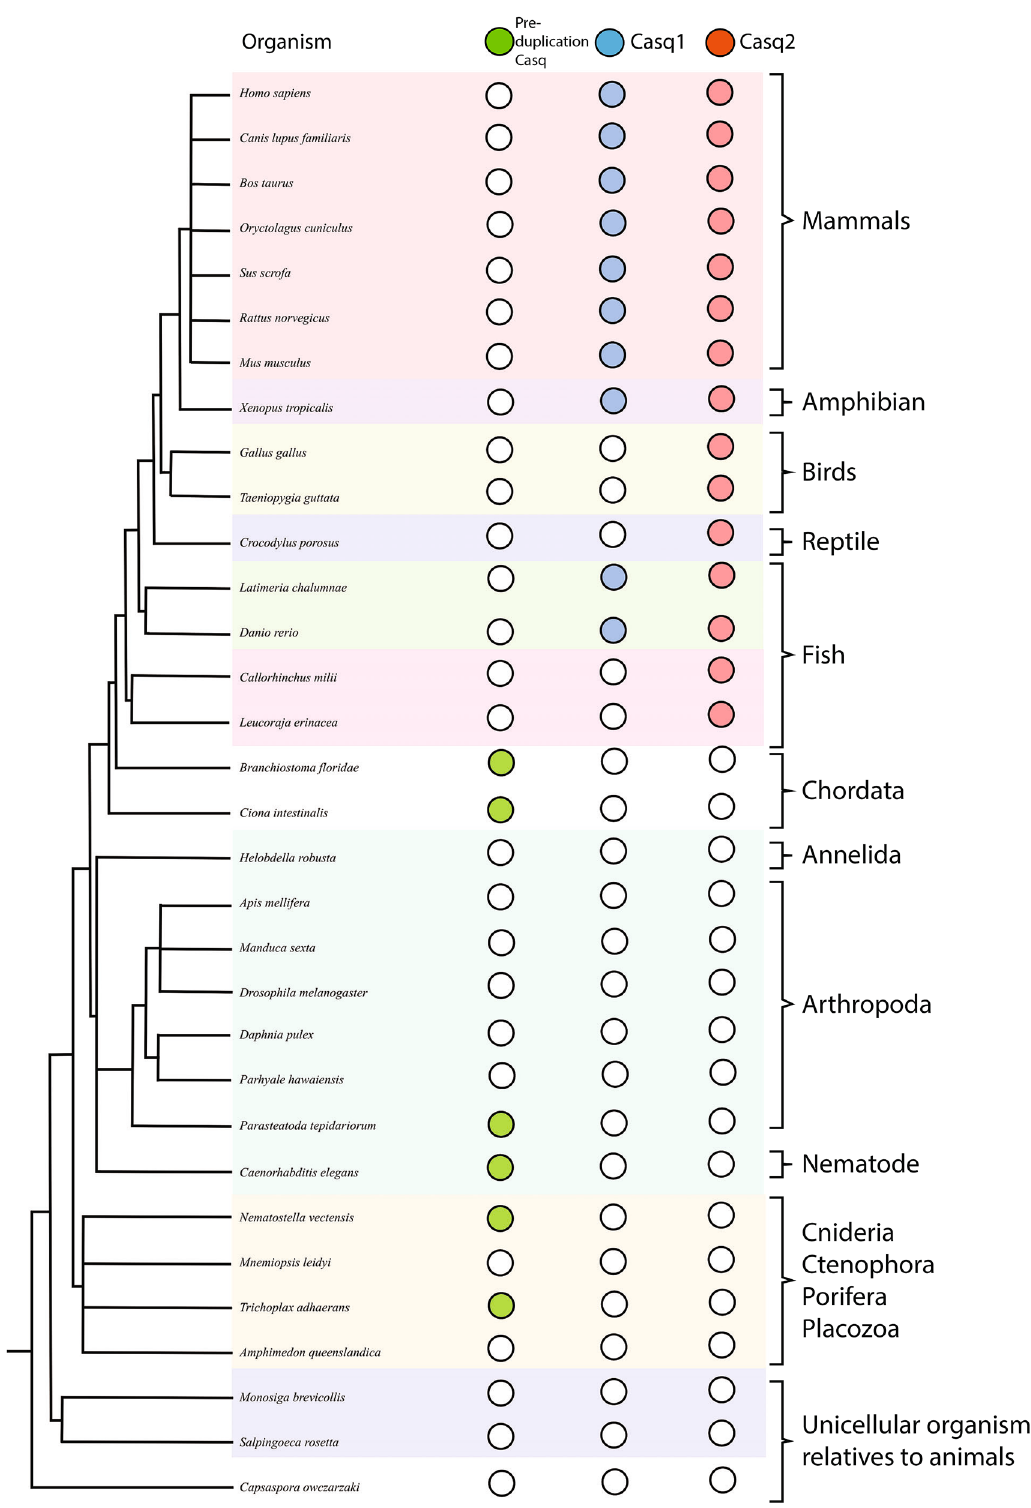
Figure 1. Calsequestrin homologues in the vertebrate and invertebrate lineages. Empty circles indicate the gene is absent. Green circles indicate the presence of pre-duplication Casq, blue circles the presence of casq1 , and red circles the presence of casq2